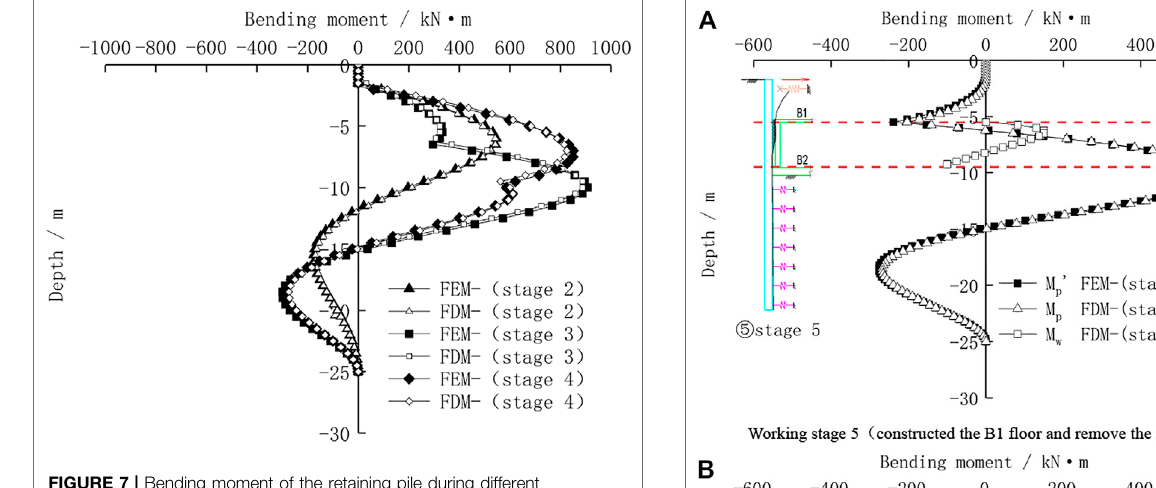
FIGURE 7 | Bending moment of the retaining pile during different excavation stages.